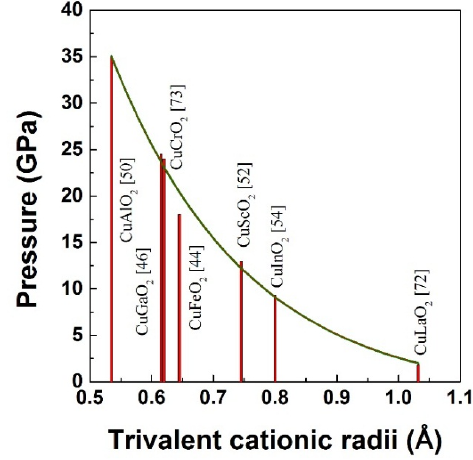
Figure 14. Transition pressure of various copper delafossites as a function of trivalent cationic radii. Green line is a fitted exponential function showing decrease in the transition pressure with the increase in trivalent cationic radii. Numbers in the bracket indicate the references.